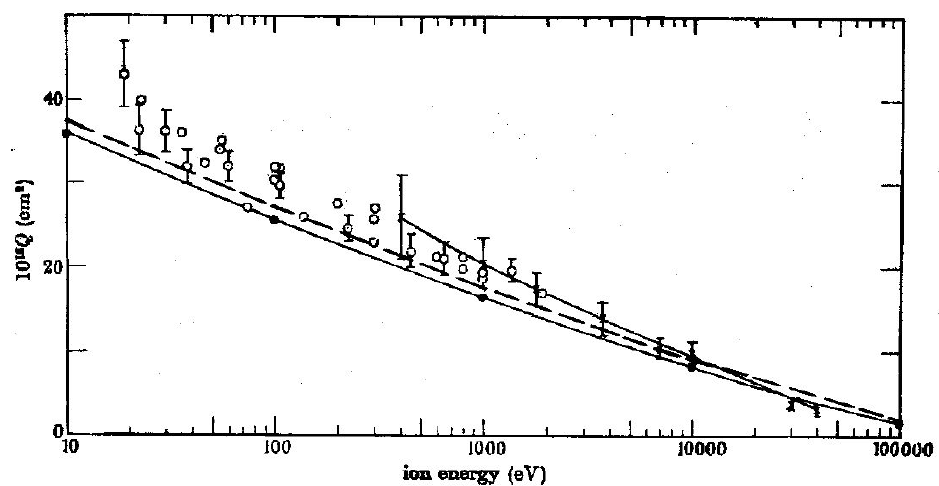
Figure 2. Experimental cross-sections of the resonant charge exchange between hydrogen atoms and low-energy protons in comparison to the corresponding theoretical cross-sections (the cross-sections are in units of 10 − 16 cm 2 ). Circles (some with error margins)—experiment reported in [17]; crosses (with error margins) connected by the solid line—experiment reported in [18]; filled circles connected by the solid line—theory of [19], allowing only for the usual hydrogen atoms; the dashed line—theory from the present paper, allowing for the SFHA [14].